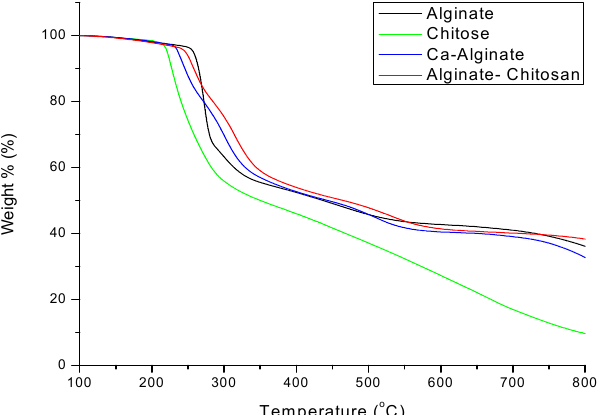
Figure 10. TGA profile of sodium alginate, chitosan, and calcium alginate composite microspheres . Table 4. Thermal cracking temperature (Td) of TGA spectrum.